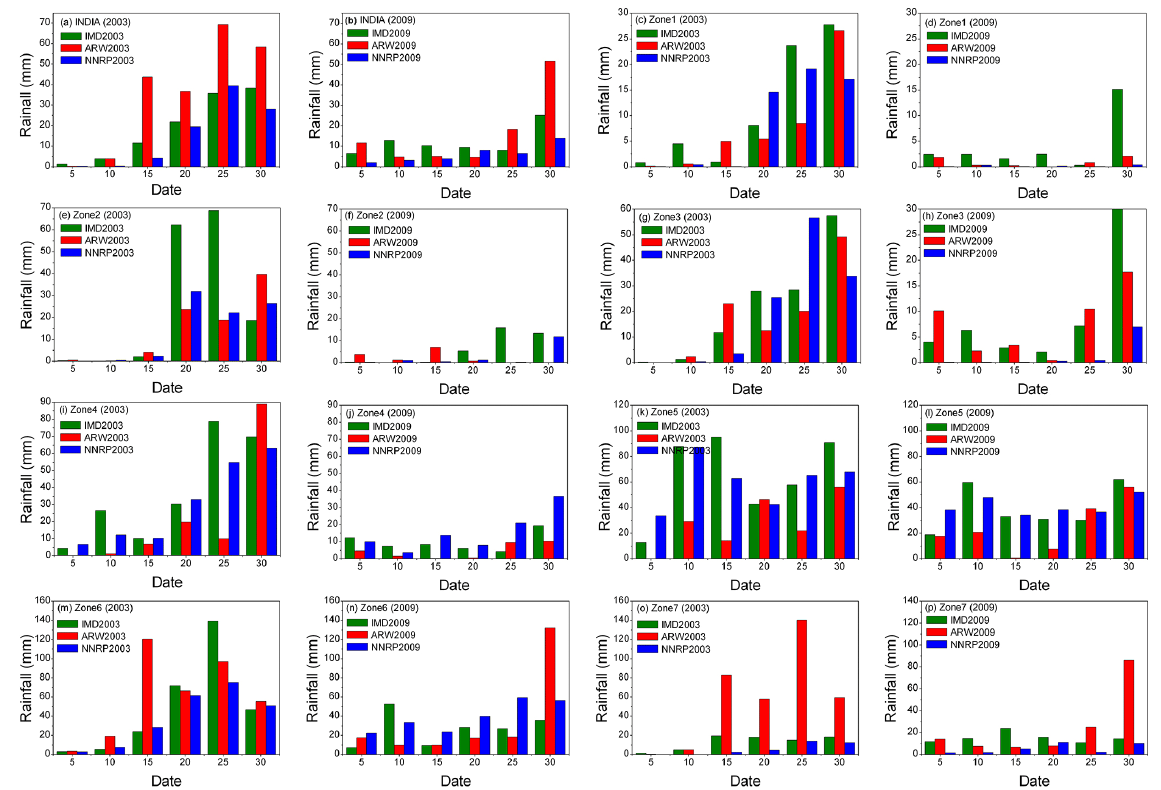
Figure 8. Variation of the 5-day mean precipitation (mmday − 1 ) for 2003 and 2009 from model, NNRP reanalysis and IMD gridded rainfall data calculated over the Indian land region (8–26 ◦ N, 66–86 ◦ E) and over different rainfall zones. The panels (a, b) , (c, d) ,... (o, p) corre- spond to India, zone 1,... zone 7 respectively for the years 2003 and 2009.